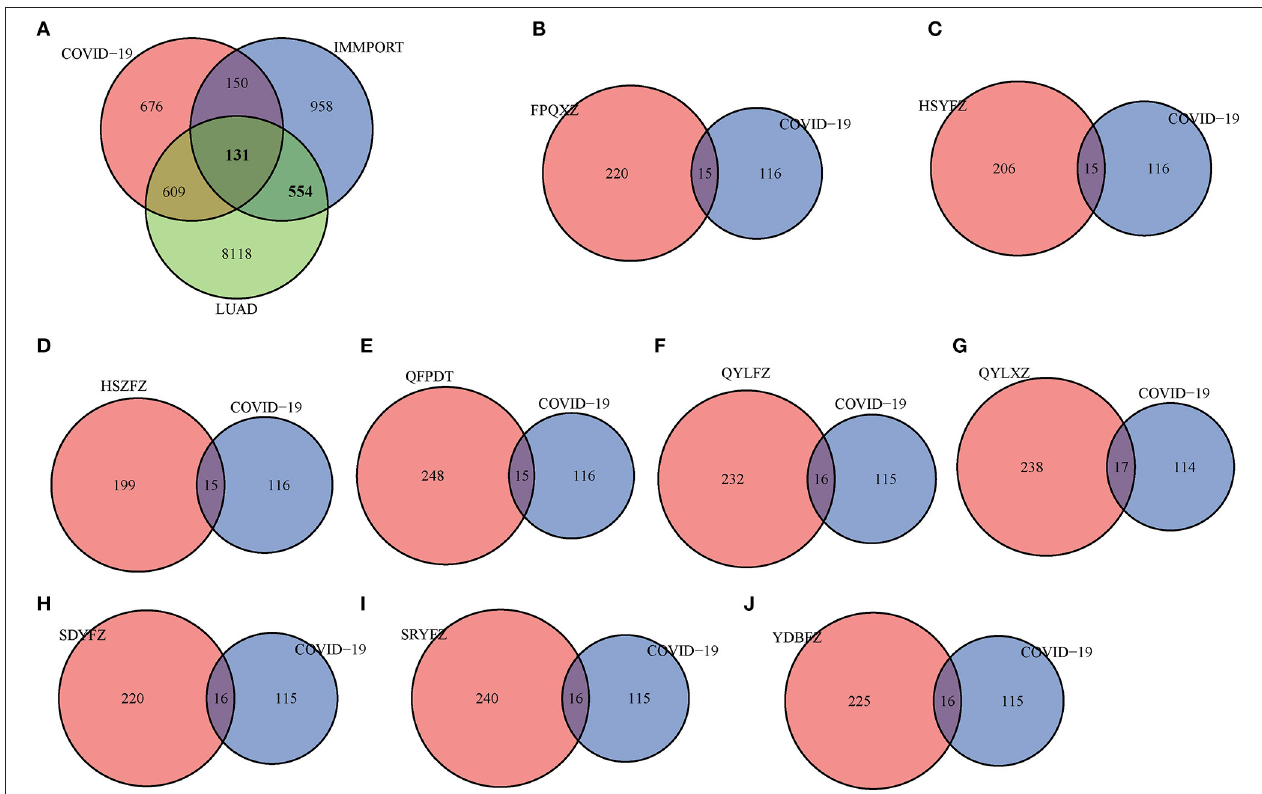
FIGURE 2 | Active ingredients and targets prescribed for COVID-19 treatment. (A) Intersection analysis of differentially expressed genes, immune-related genes, and COVID-19 related genes in CLUAD. The Venn diagram of FPQXZ (B) , HSYFZ (C) , HSZFZ (D) , QFPDT (E) , QYLFZ (F) , QYLXZ (G) , SDYFZ (H) , SRYFZ (I) , and YDBFZ (J) with COVID-19 immune-related genes in